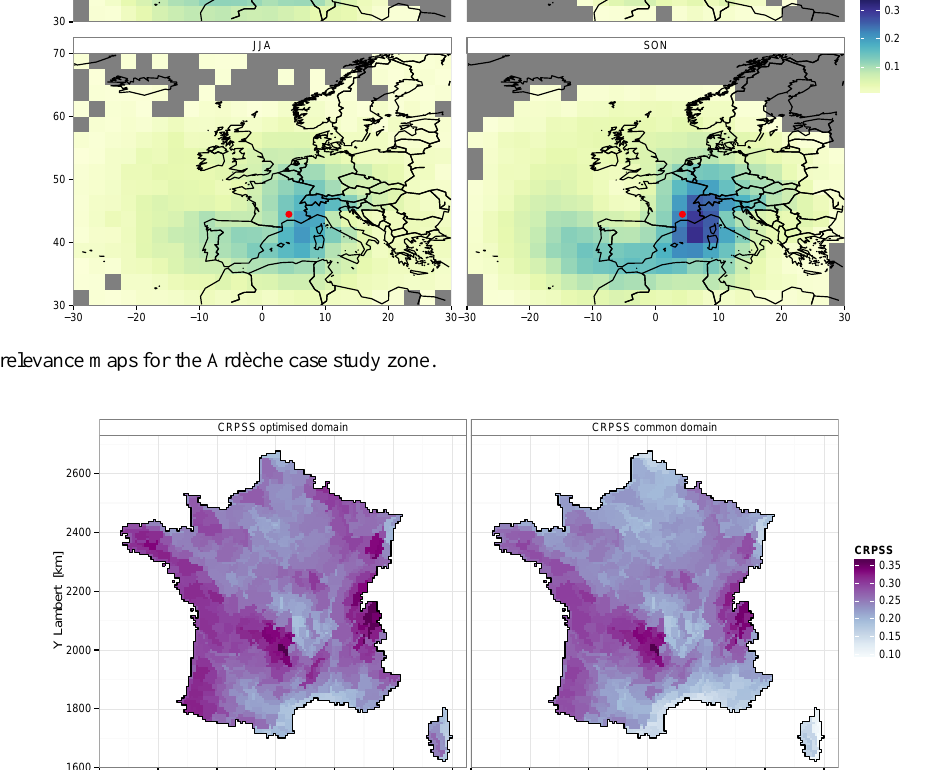
Fig. 5. Left panel: CRPSS obtained with the best domain found during optimisation. Right panel: CRPSS obtained with a domain optimised for average precipitation over France. Dark purple corresponds to a higher (that is, better) skill score, while light blue corresponds to lower Fig. 5. Left: CRPSSobtained with the best domain found during optimisation. Right: CRPSSobtained with a domain optimised for France average precipitation. Dark purple corresponds to a higher, that is better, skill score, while light blue corresponds to lower skill.